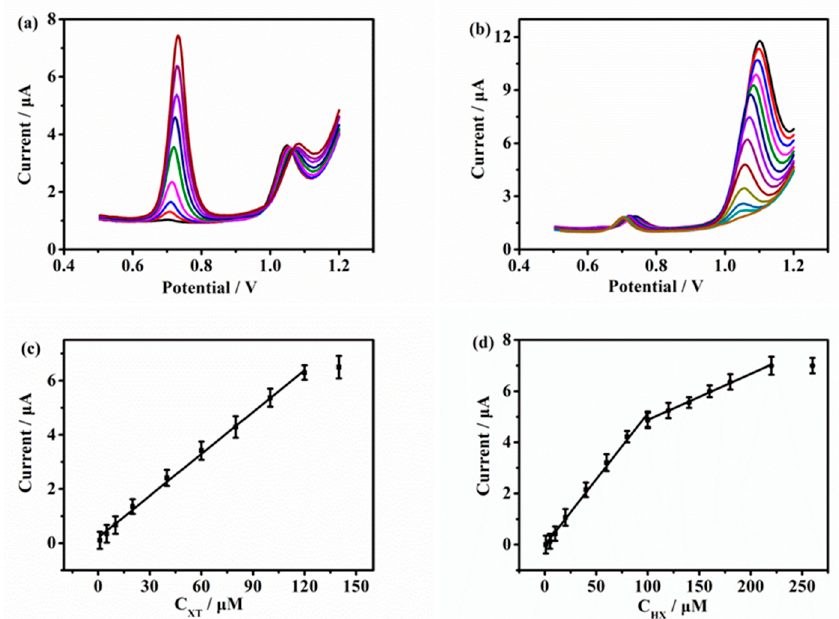
Figure 6. ( a ) DPVs of p-Gly/rGO/GCE with 20 μ M HX for the determination of 1 − 120 μ M XT in 0.1